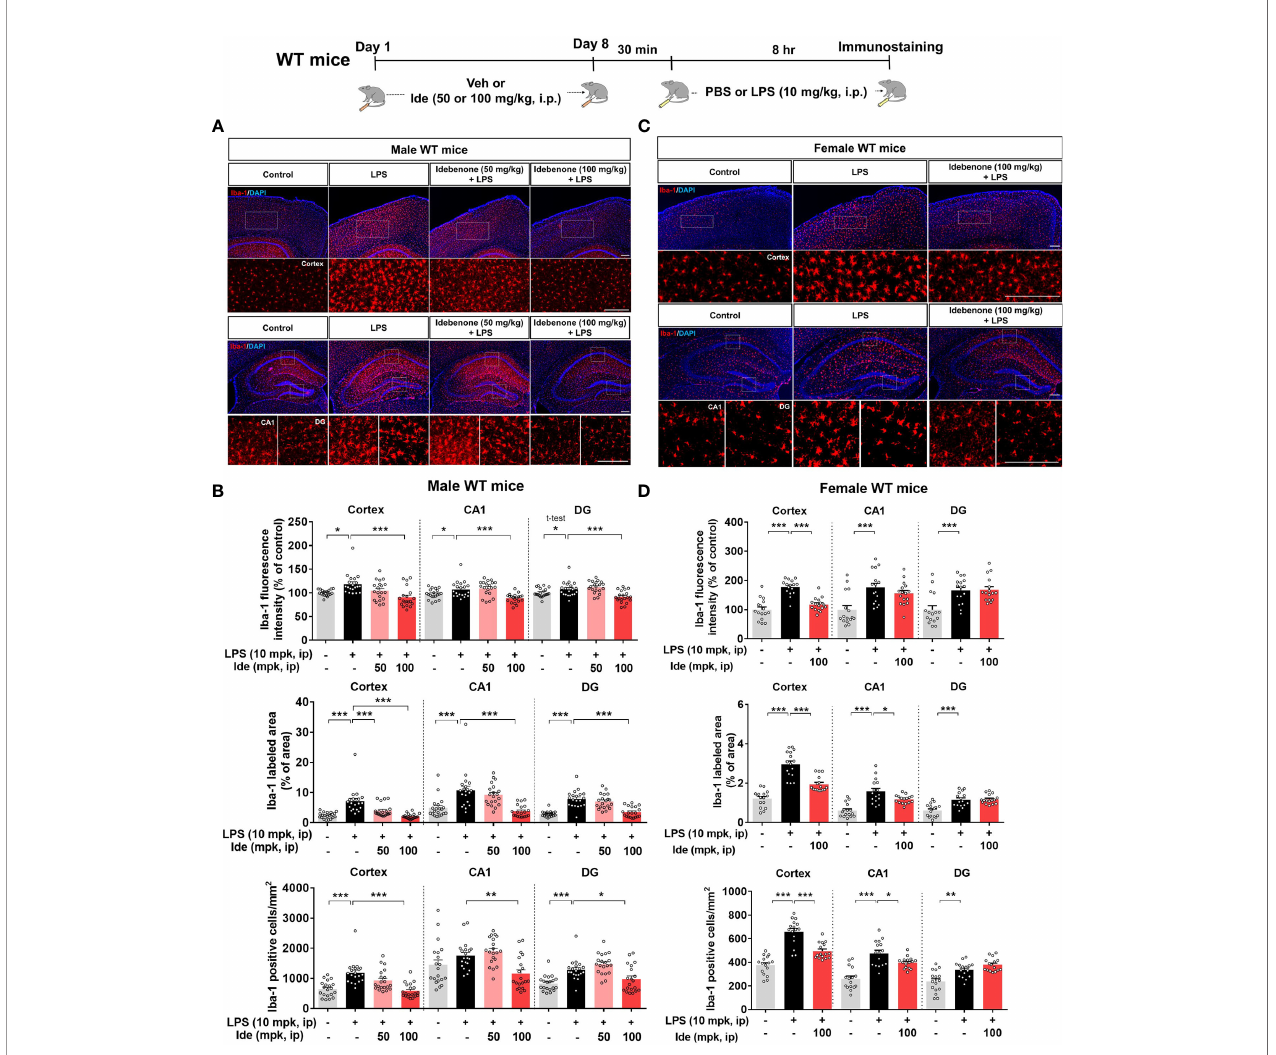
FIGURE 3 | Idebenone inhibits LPS-mediated microglial activation, hypertrophy, and proliferation in male and female wild-type mice. (A, C) Representative image of Iba-1 immuno fl uorescence in the cortex and hippocampus. Idebenone (50 or 100 mg/kg, i.p.) or vehicle was administered to male and female wild-type mice daily for 8 consecutive days. Thirty minutes after the fi nal injection, LPS (10 mg/kg, i.p.) or PBS was administered, and 8 h later, the mice were sacri fi ced, and brain tissue was immunostained with an anti-Iba-1 antibody. (B, D) Quanti fi cation of the fl uorescence intensity of Iba-1; Iba-1-immunolabeled area; and number of Iba-1-positive cells (Male WT: n = 20 brain slices from 5 mice/group; Female WT: n = 16 brain slices from 4 mice/group). *p < 0.05, **p < 0.01 and ***p < 0.001. Scale bar = 200 m